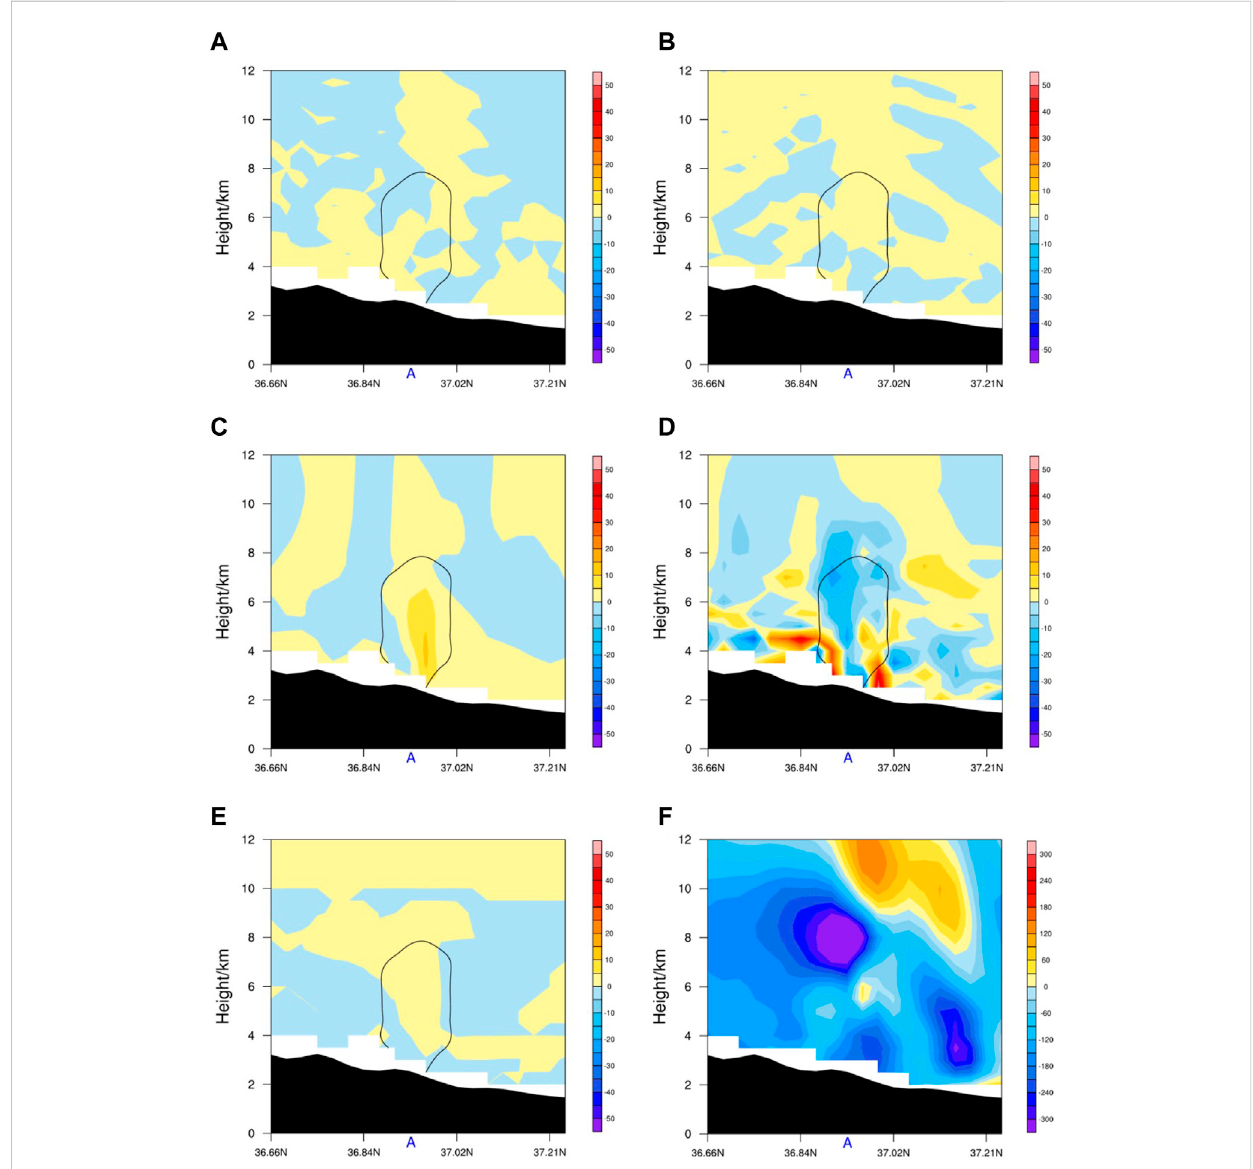
FIGURE 5 Cross sections of the (A) zonal pressure advection term (shadings, units: kg m − 1 s − 3 ), (B) meridional pressure advection term (shadings, units: kg m − 1 s − 3 ), (C) vertical pressure advection term (shadings, units: kg m − 1 s − 3 ), (D) three-dimensional divergence forcing term (shadings, units: kg m − 1 s − 3 ), (E) diabatic forcing term (shadings, units: kg m − 1 s − 3 ), and (F) pressure change after 6 s (shadings, units: Pa) along 78.91 ° E at 0700 UTC on 15 June 2021. The black solid line denotes the hydrometeor mixing ratio of 0.2 g kg − 1 in panels (A – E)